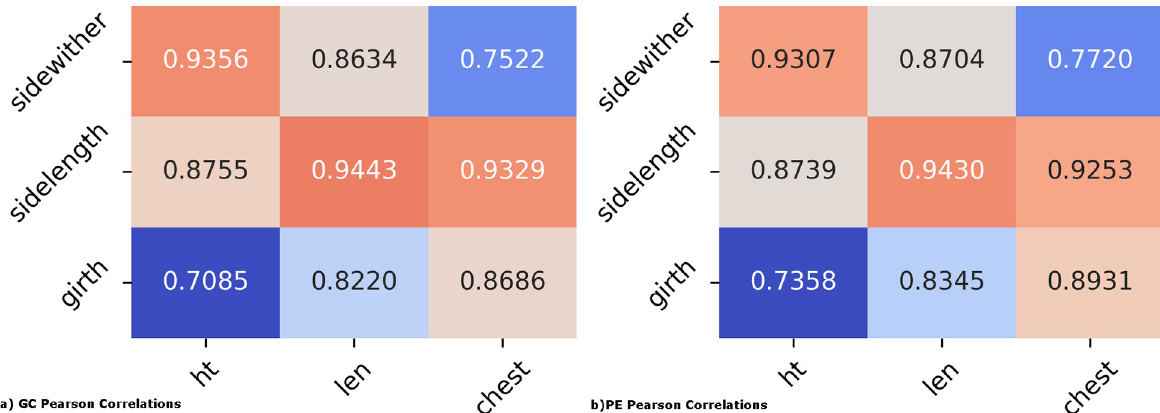
S1 Table. Table of figures, input, process, and output comparison for GrabCut versus Pre-